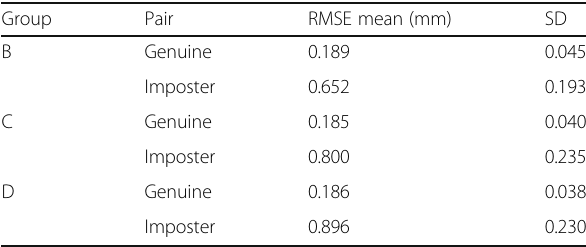
Table 2 Descriptive statistics of the genuine and the imposter pairs in experiment